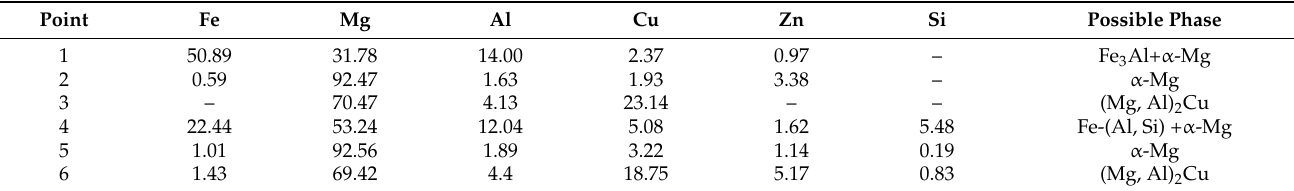
Figure 7. micro ‐ XRD patterns of the reactive layer with different Si contents: ( a ) Cu − 0%Si and ( b ) Cu − 5%Si.